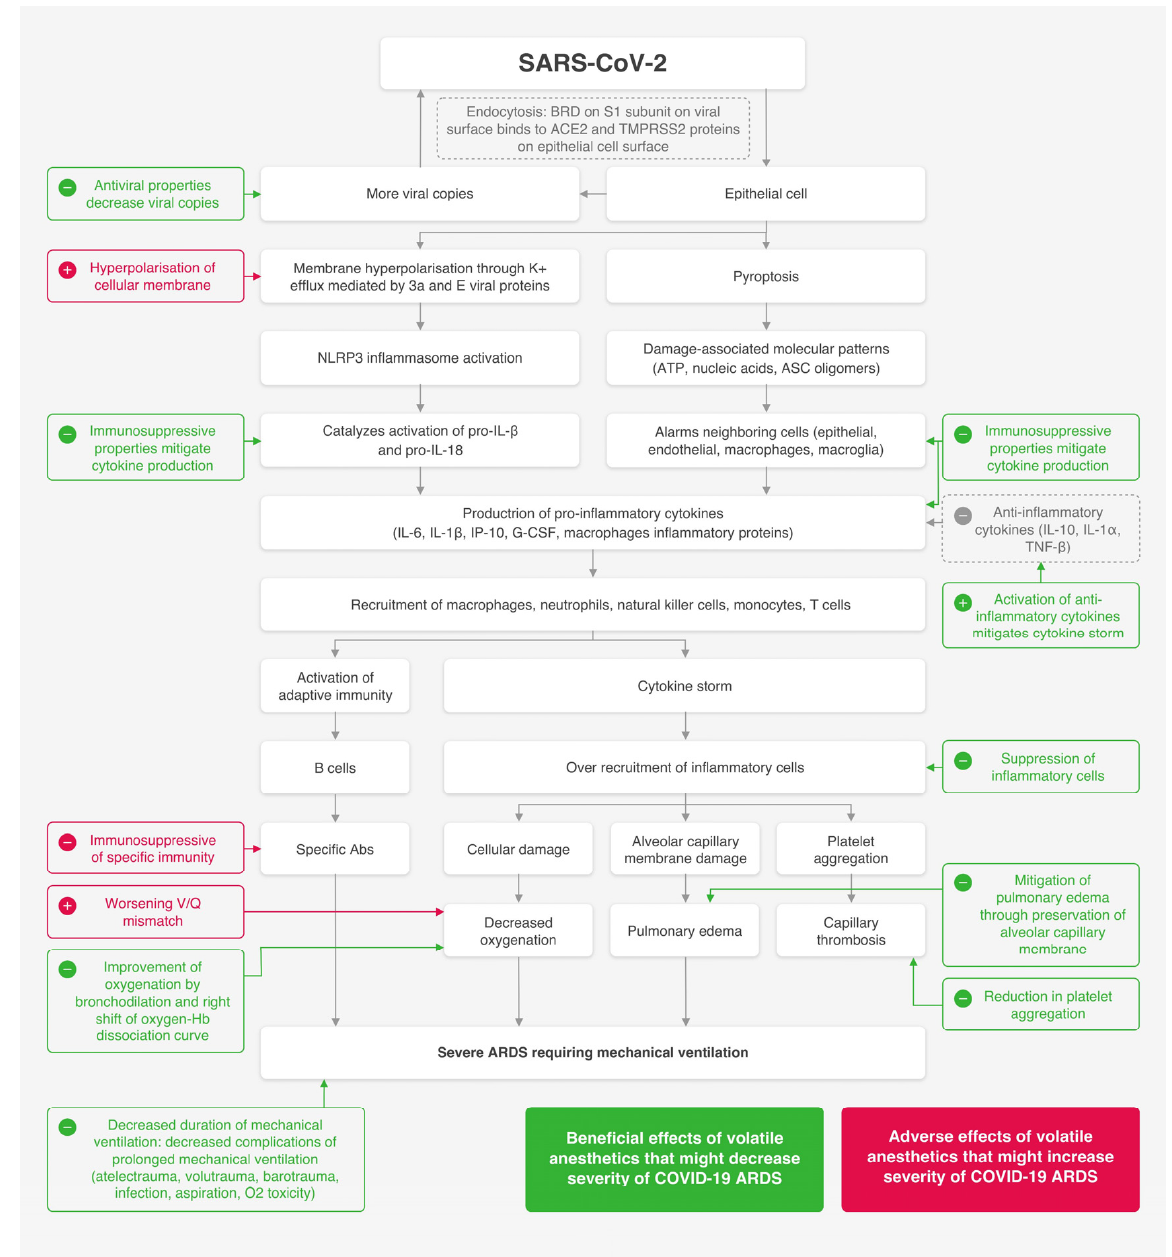
Figure 1. A summary of beneficial and adverse events associated with the use of volatile anesthetics for sedating mechanically ventilated COVID-19 ARDS patients.